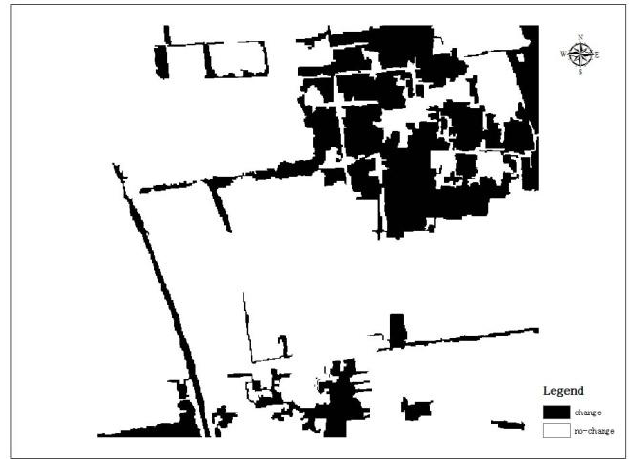
Figure 3. The actual change map referenced in the accuracy assessment.